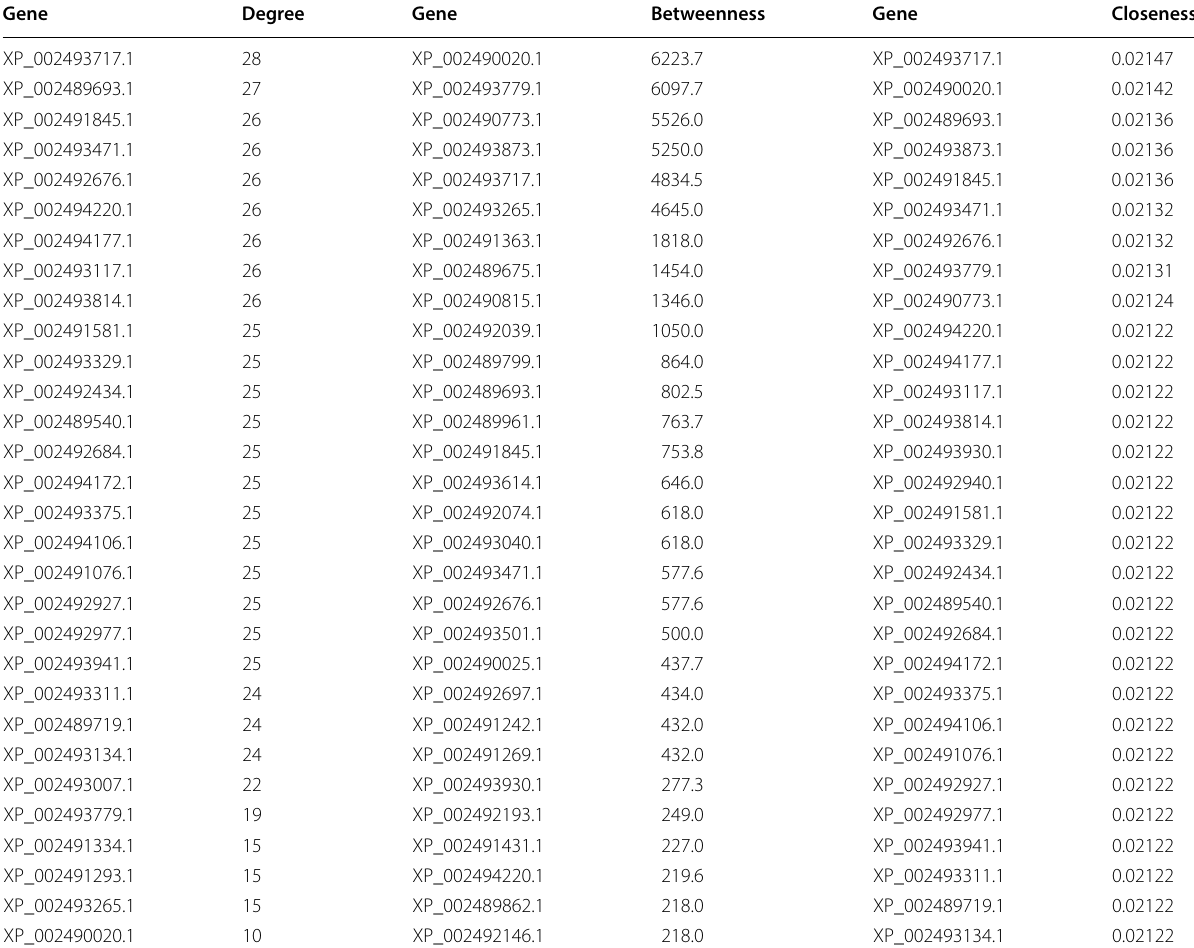
Table 3 Top 30 genes with higher topological properties in the protein–protein interaction network